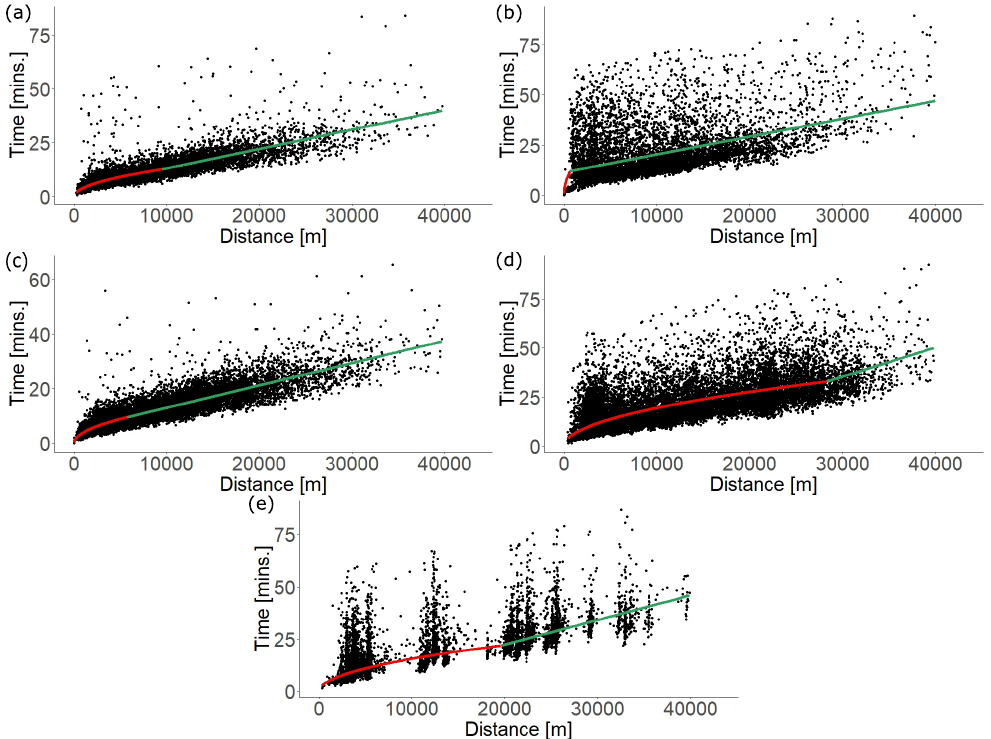
Figure 11. The dependence of travel time on the travelled distance for ( a ) “sps_sp”, ( b ) “sps_ps”, ( c ) “sphs_sp”, ( d ) “sphs_ph”, and ( e ) “sphs_hs” movements. The function T ( d ) is displayed by red on interval (cid:104) 0, d 0 (cid:105) and by green on interval (cid:104) d 0 , 40,000 (cid:105)